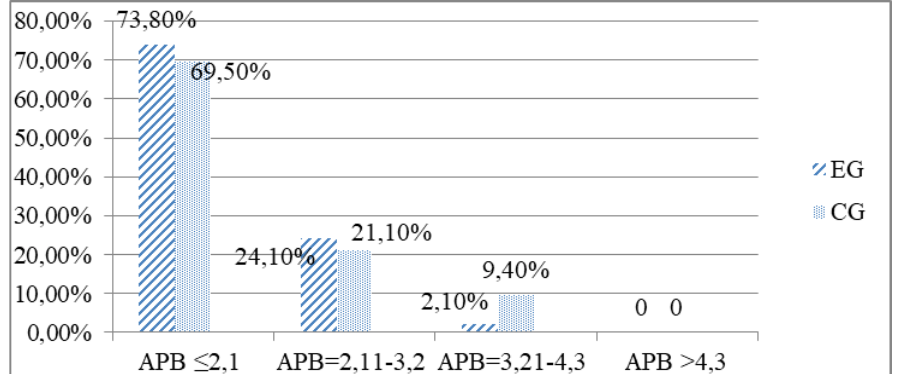
Fig. 1. Results of measuring the level of adaptive capabilities of the students at the beginning of the experiment, %. Comment: АPB – adaptive potential of Baevsky’s. EG – experimental group. CG – control group.